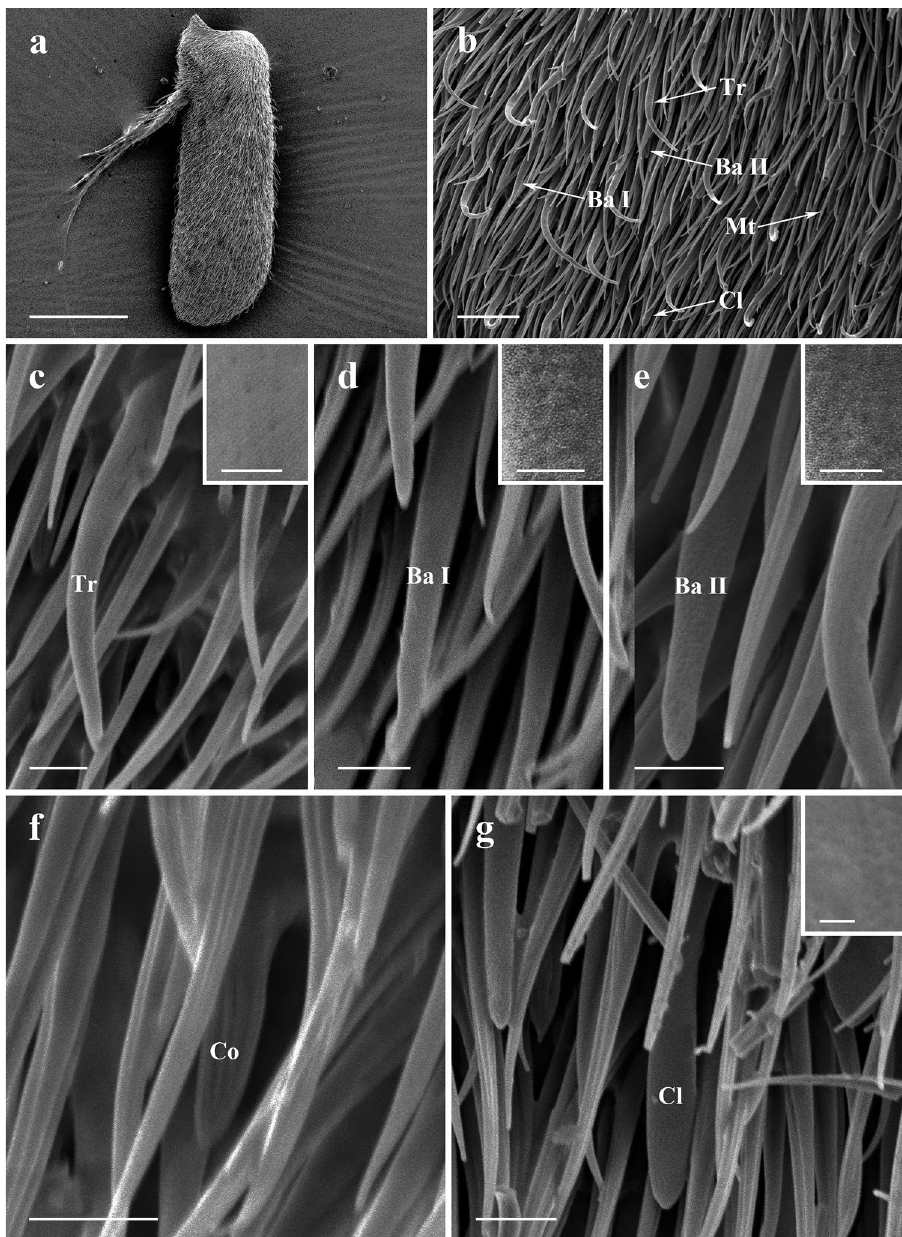
Figure 4. SEM micrographs of features on antennal postpedicel of male Lispe orientalis . ( a ) Posterior surface of antennal postpedicel. ( b ) Distribution of different types of sensilla on antennal postpedicel. ( c ) Trichoid sensilla, box showing micropores on the surface. ( d ) Subtype I basiconic sensilla, box showing micropores on the surface. ( e ) Subtype II basiconic sensilla, box showing micropores on the surface. ( f ) Coeloconic sensilla. ( g ) Clavate sensilla, box showing micropores on the surface. Ba I subtype I basiconic sensilla, Ba II subtype II basiconic sensilla, Co coeloconic sensilla, Cl clavate sensilla, Mt microtrichia, Tr trichoid sensilla. Scale bars: ( a ) 150 μm; ( b ) 10 μm; ( c–e,g ) 2.5 μm, 0.5 μm in box; ( f ) 2.5